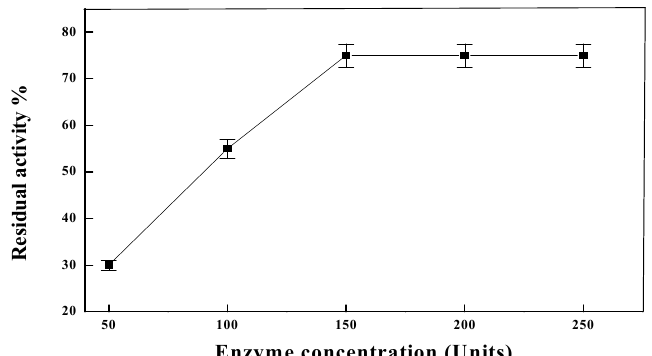
Figure 1. The effect of the soluble α -amylase concentration on the rate of immobilization. The immobilization process was performed at pH 7.2 with 4% ( w / v ) cyanuric chloride. Each point represents the mean of three experiments ± S.E. Please add one space between % and activity in the y axis in the Figures 1 and